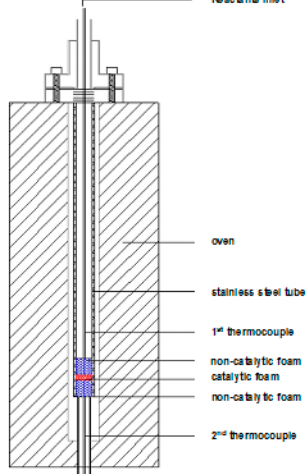
Figure 12. View of the test tubular reactor.